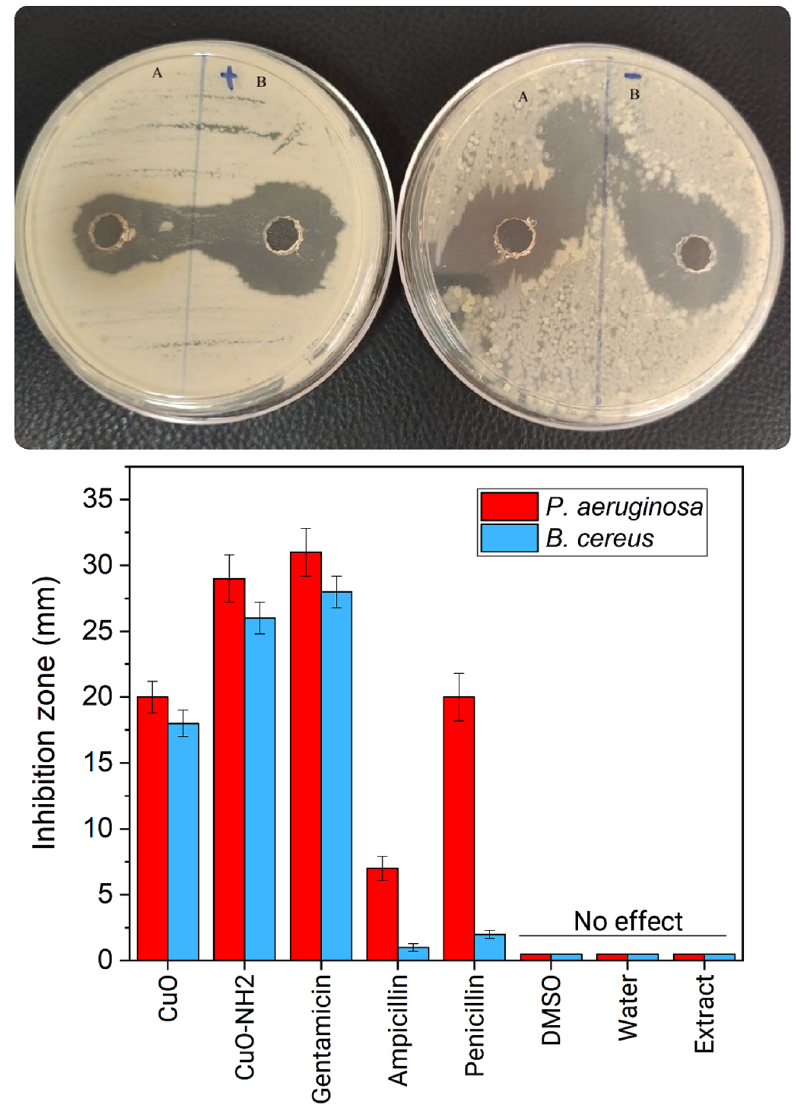
Figure 5. Antibacterial activity of the synthesized ( A ) CuO, ( B ) CuO–NH 2 (nano)particles.